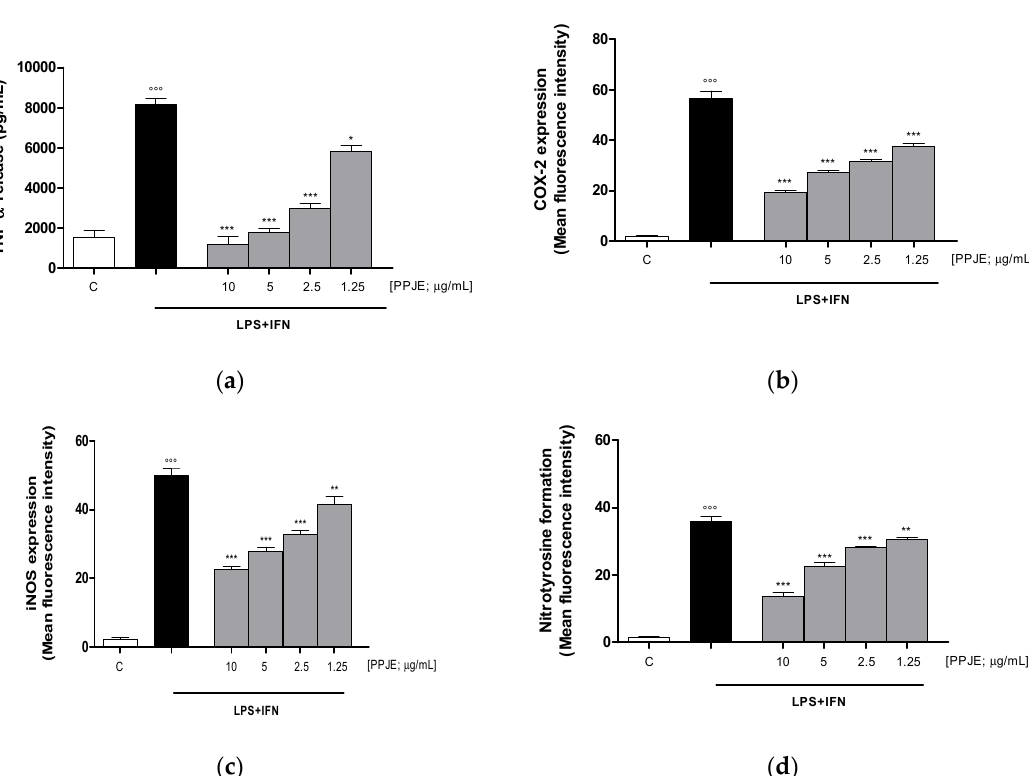
Figure 2. E ff ect of pomegranate juice extract (PPJE) (10–1.25 µ g / mL) on proinflammatory mediators’ inhibition in lipopolysaccharides (LPS) + interferon- γ (IFN) treated IEC-6. TNF- α release ( a ), evaluated by ELISA assay, COX-2 ( b ) and iNOS ( c ) expression and nitrotyrosine formation ( d ), evaluated by the cytofluorimetric technique. Data are expressed as pg / mL or mean of fluorescence intensity. C denotes control group. ***, ** and * denote respectively p < 0.001, p < 0.01 and p < 0.05 vs. LPS + IFN; ◦◦◦ denotes p < 0.001 vs.